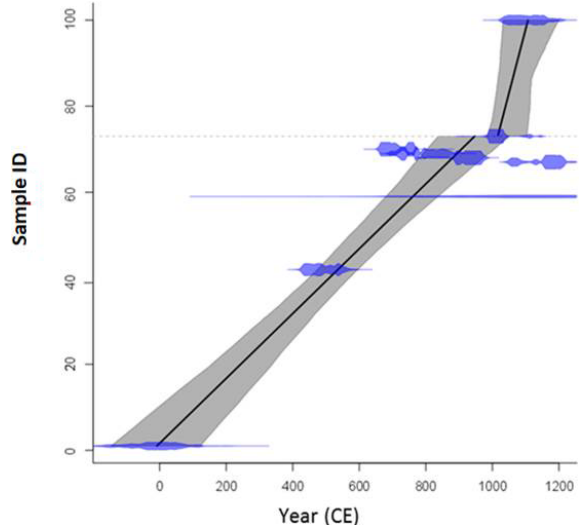
Figure 3. Age model for the Monte Perdido ice sequence based on linear interpolation of 14 C data (Table 3), obtained using the clam software (Blaauw, 2010; Blaauw et al., 2019). Y axis indicates the number of samples from MP-0 to MP-100 (see Fig. 2). The dates appear as the calendar-age probability distributions in blue, while the black line is the resulting depth–age model and the grey enve- lope shows the 95% confidence interval. Note the hiatus located at 73m indicated by a dashed line. The error in sample MP59m is so high that it appears as a horizontal